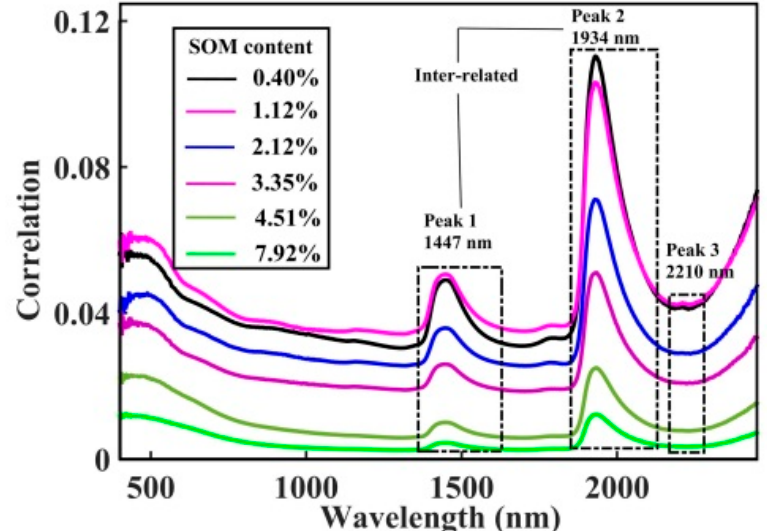
Figure 6. Plots the correlation strength along the diagonal lines of the synchronous two-dimensional correlation spectroscopy (2D-COS) in Figure 5 when moisture is treated as the perturbation variable in each set of the six different SOM content data.